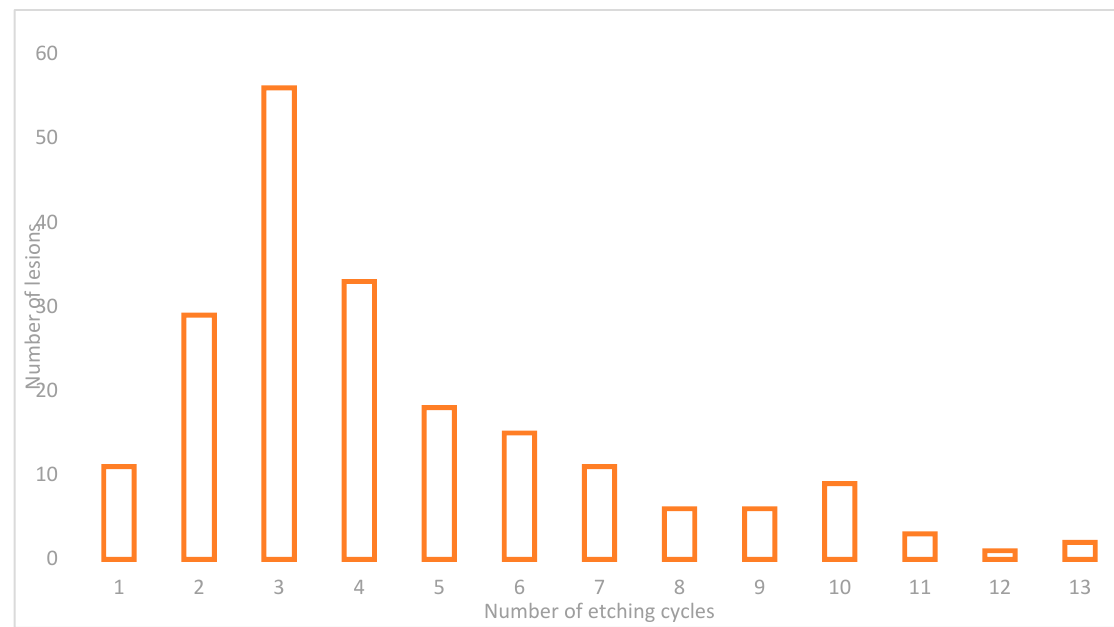
Figure 12. Number of etching cycles performed for each lesion.